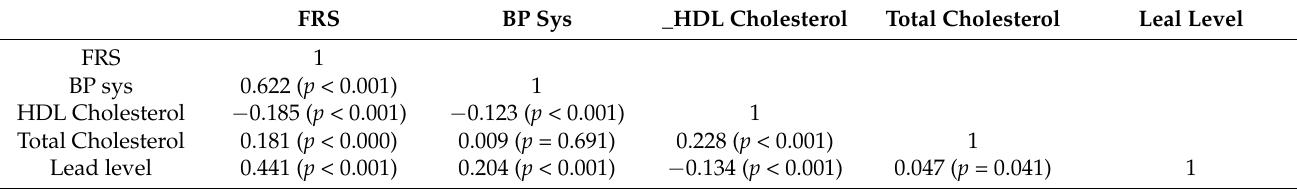
Table 2. Correlation for Sys BP, HDL, Total Cholesterol and Lead